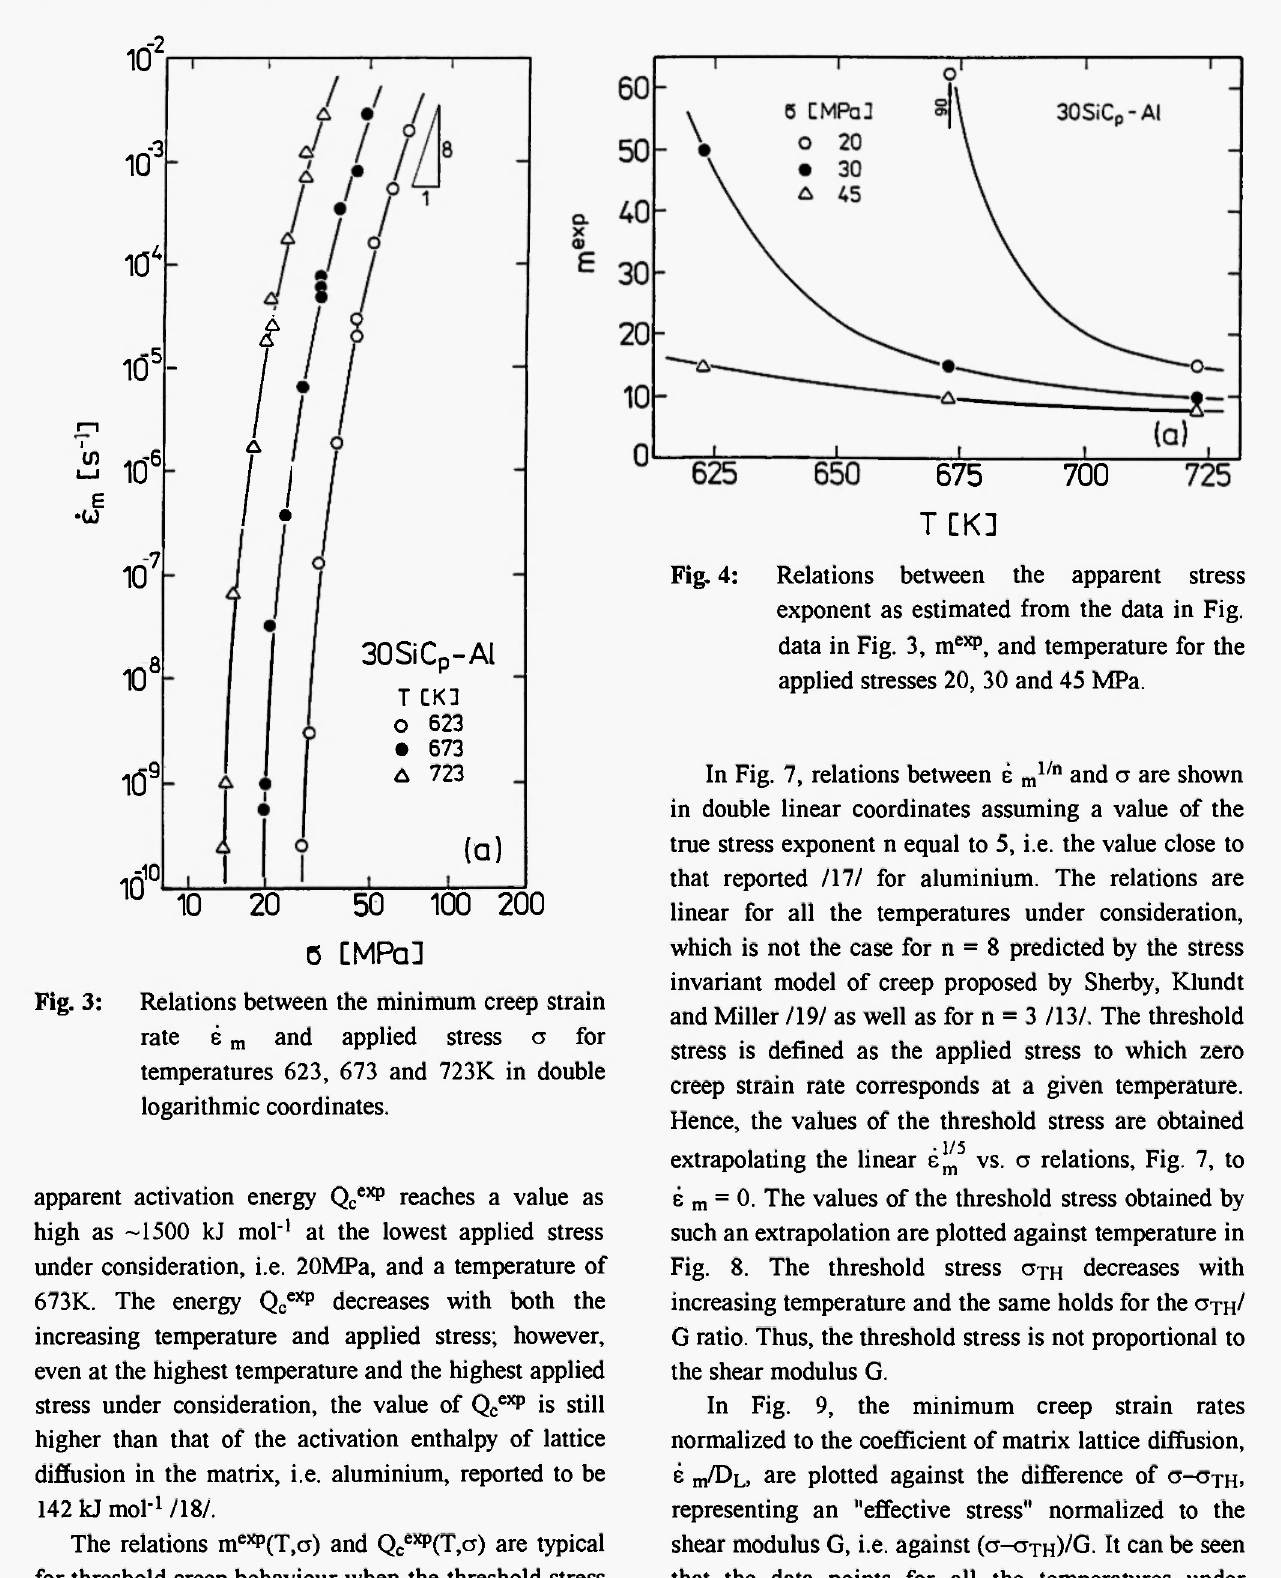
decreases with ΤΗ / ΤΗ , ΤΗ )/G. It can be seen TH